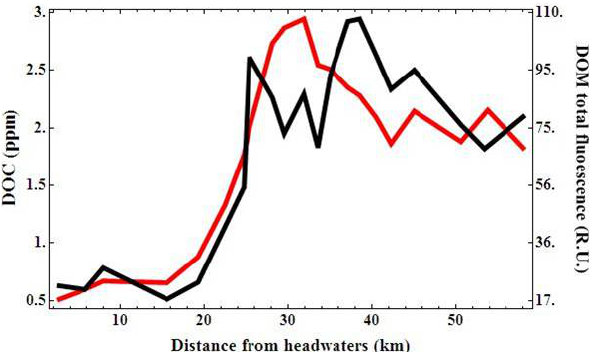
Fig. 5. DOC (red line) and DOM total fluorescence (black line) along the Tordera river main stem. DOC and total fluorescence sig- nificantly co-vary ( r 2 = 0 . 695, d.f. = 20, p <